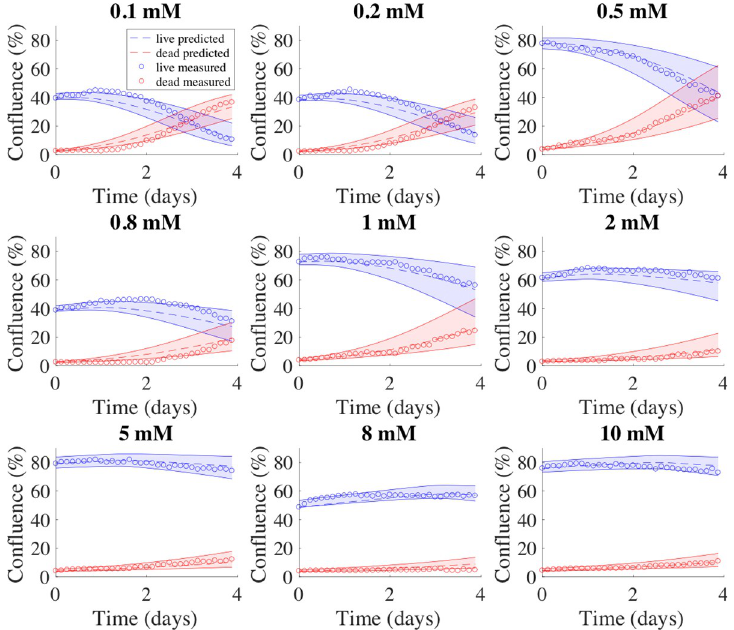
Fig 5. Model predictions for MDA-MB-231 cells. Example model predictions from one validation set of MDA-MB- 231 cells are shown in dashed lines. In each panel, data measured from experiments are shown in circles, while the 95% confidence intervals for the predicted tumor cell growth and dead cell accumulation numbers are shown with shaded regions between the solid curves; with blue indicating live cells, and red indicating dead cells. The initial glucose level is shown above each plot. For this validation set, the model prediction accuracy was 86.9 ± 7.4% and 69.6 ± 9.4% for live and dead cells,